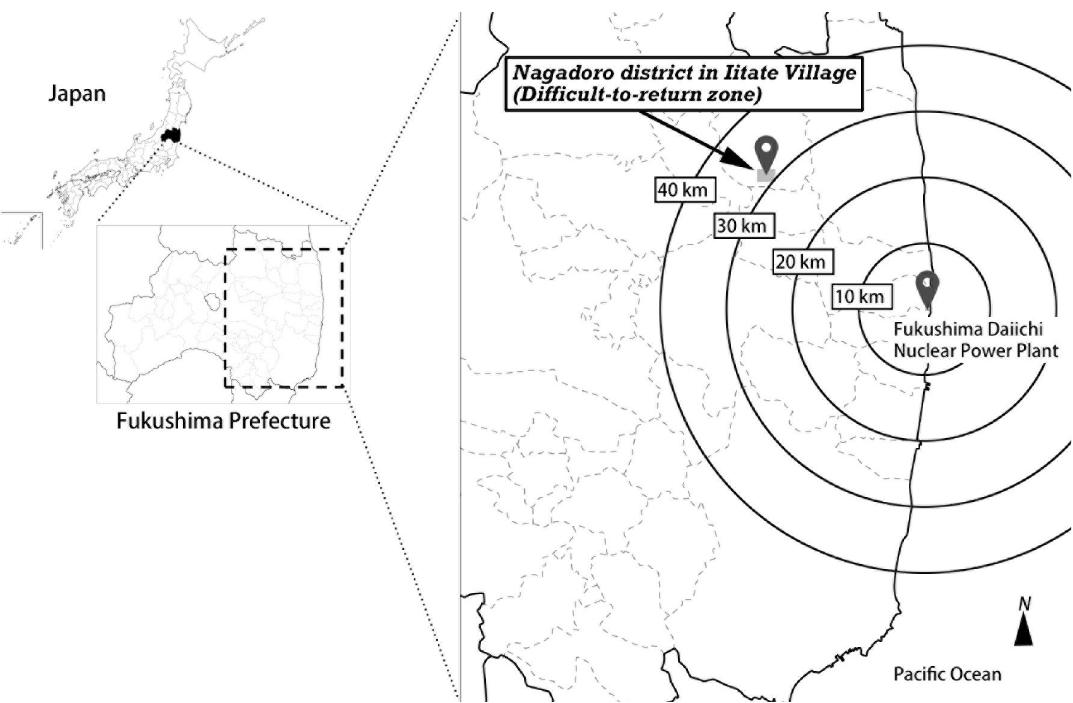
Fig 1. Location of Nagadoro district in Iitate Village, Fukushima prefecture. Concentric circles indicate the distance from the Fukushima Daiichi nuclear power plant.